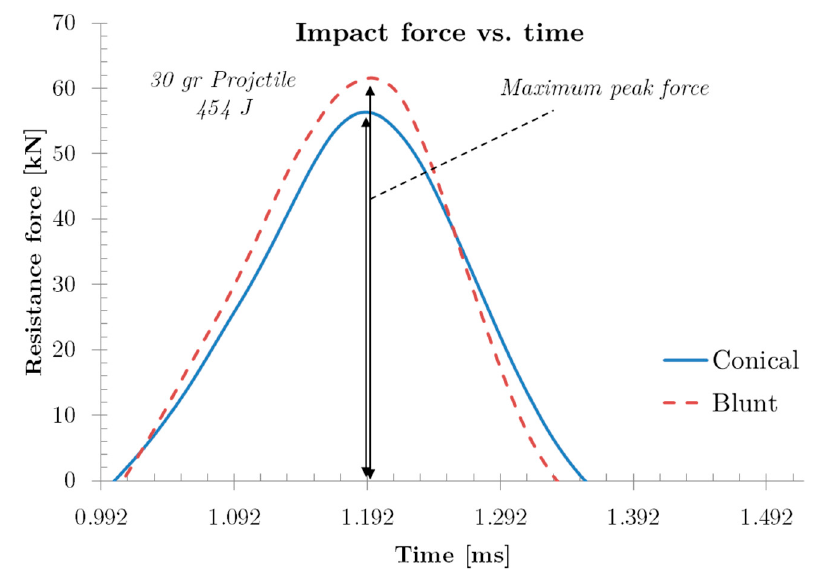
Figure 8. Detail of peak force obtained from resistance force history.